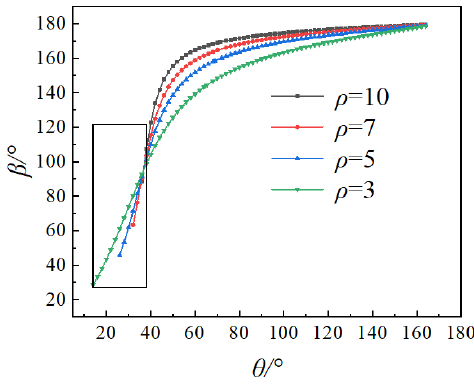
Figure 9. The curves of different ρ at λ = 0.8.